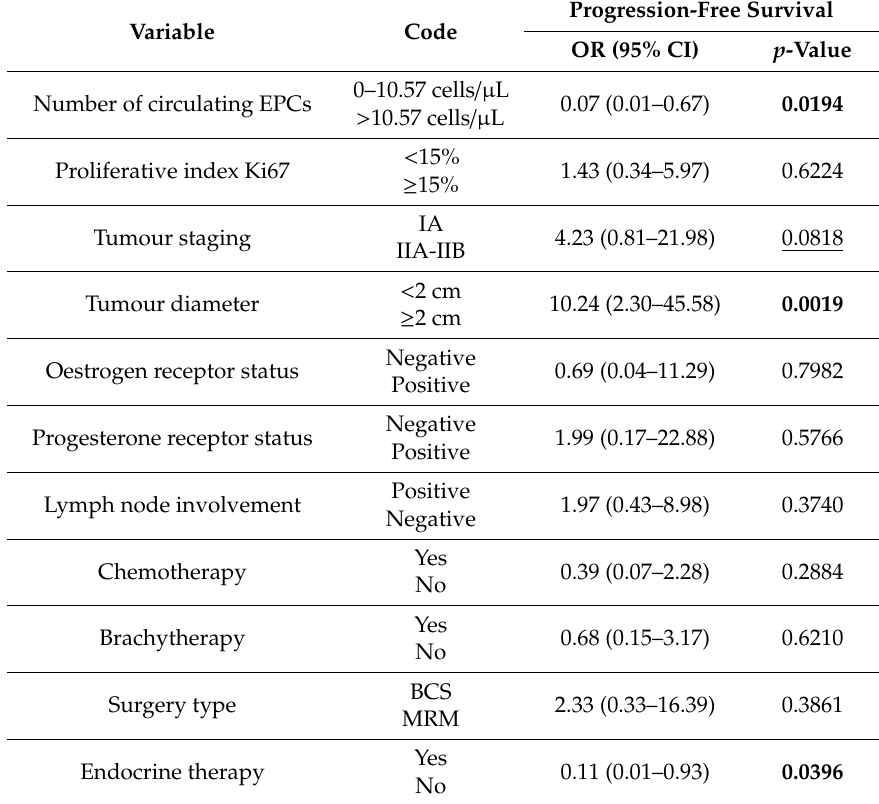
Table 2. Logistic regression analysis of progression-free predictors in breast cancer